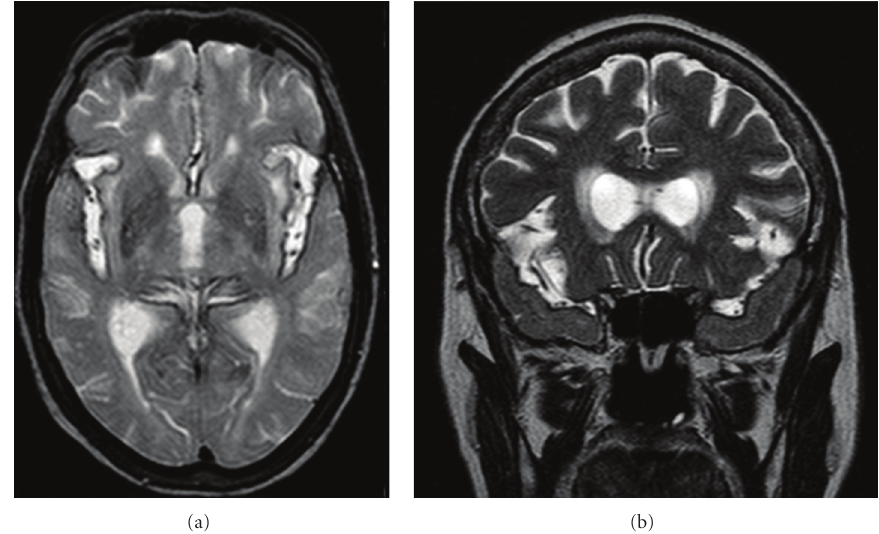
Figure 3: T2 sequences in axial (a) and coronal (b) slices illustrate the widespread of hypointensities in the bilateral frontotemporal cortex of Patient 2, thus suggesting strong iron